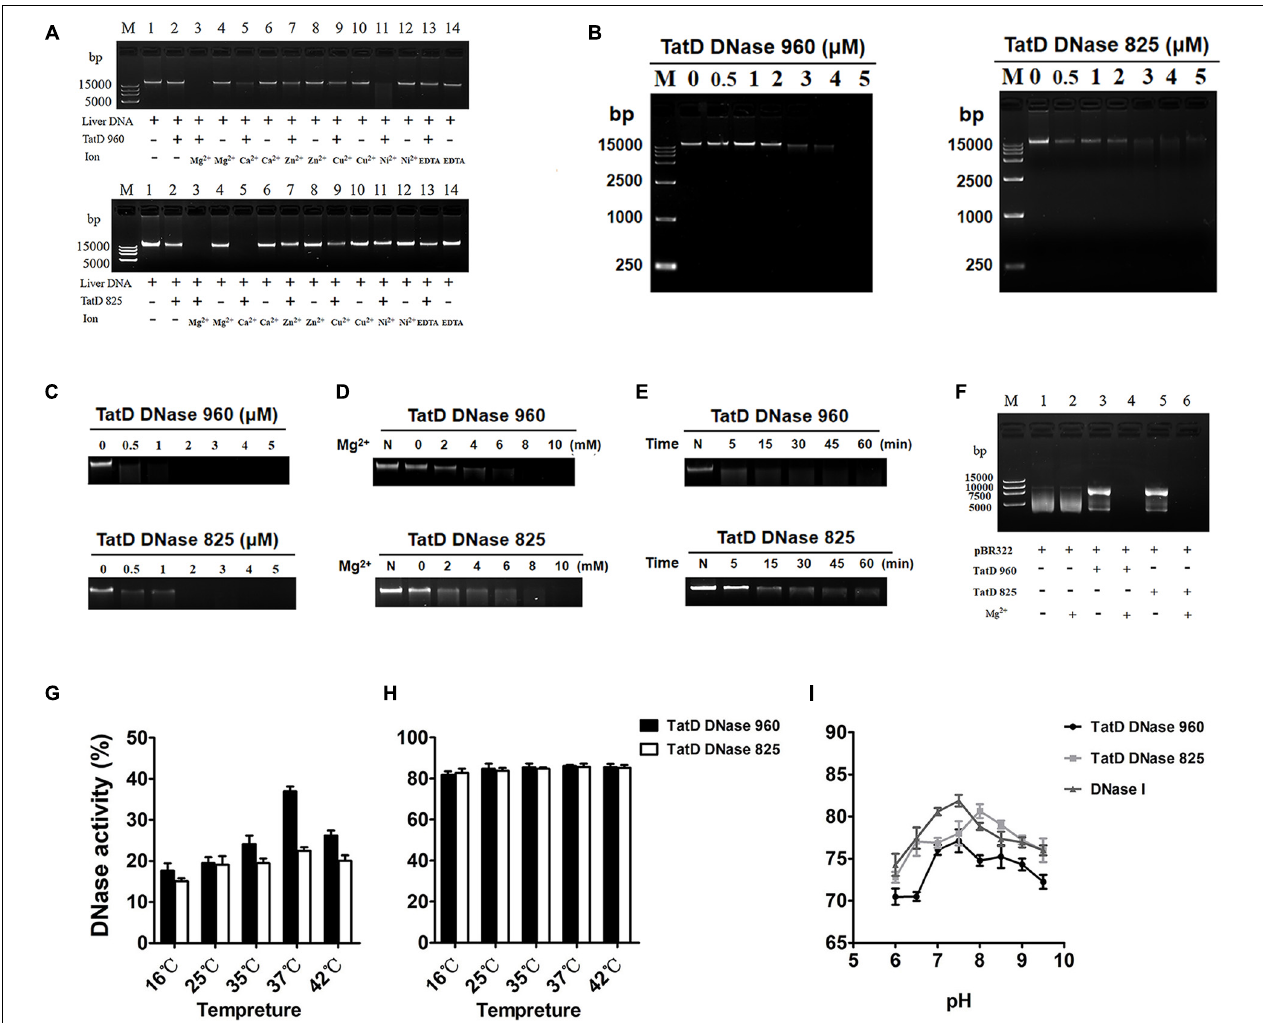
FIGURE 3 | The DNase activity of TpTatDs. (A) The effects of divalent metal cations on the DNase activity of TpTatDs. Linear DNA was incubated in the absence (lanes 1, 4, 6, 8, 10, 12, and 14) or presence (lanes 2, 3, 5, 7, 9, 11, and 13) of TpTatDs and a variety of metal ions for 60 min at 37 ◦ C. DNA was visualized by agarose gel electrophoresis. The concentration of metal ions was 10 mM. (B) TpTatDs can weakly degrade linear DNA without metal cations. TpTatDs at various concentrations (0–5 µ M) were incubated with linear DNA (200 ng) in PBS (pH = 7.4) at 37 ◦ C for 1 h. (C,D) Mg 2 + can promote the hydrolysis of linear DNA by TpTatDs. TpTatDs (2 µ M) with Mg 2 + (10 mM) were able to completely hydrolyze DNA at 37 ◦ C for 1 h. (E) TatD DNase 960 (5 µ M) was able to completely hydrolyze linear DNA within 1 h, and TatD DNase 825 (5 µ M) hydrolyzed most of the linear DNA. (F) The ability of TpTatDs to digest plasmid DNA substrates. Two hundred nanograms of plasmid pBR322 was incubated with 2 µ M TatD DNase 960/TatD DNase 825 at 37 ◦ C for 1 h. Mg 2 + (10 mM) was added to the complex as a stimulator. Mg 2 + can promote TatD DNases to hydrolyze pBR322. (G,H) Analysis of the effect of temperature on the DNase activity of TpTatDs in the absence